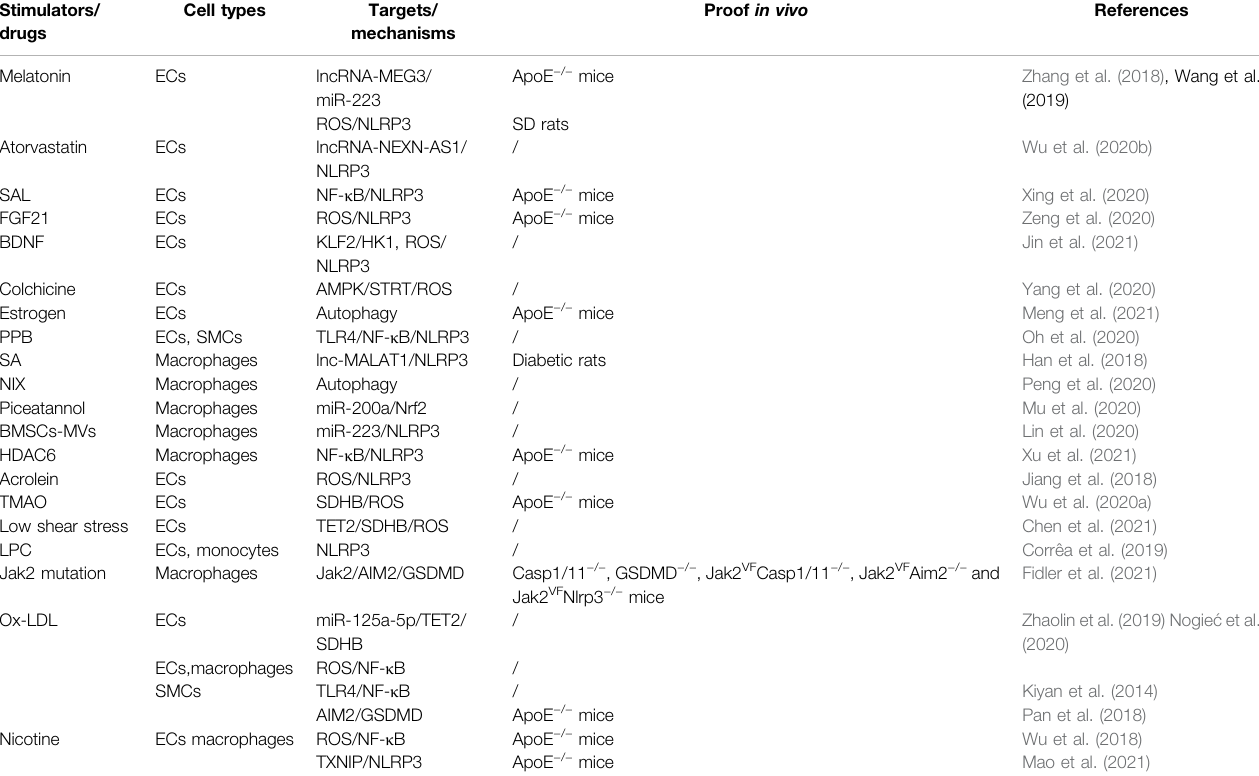
TABLE 1 | Mechanisms of drugs and stimulators regulating pyroptosis in the atherosclerosis. White: Positive factors of pyrotosis. Gray: Negative factors of